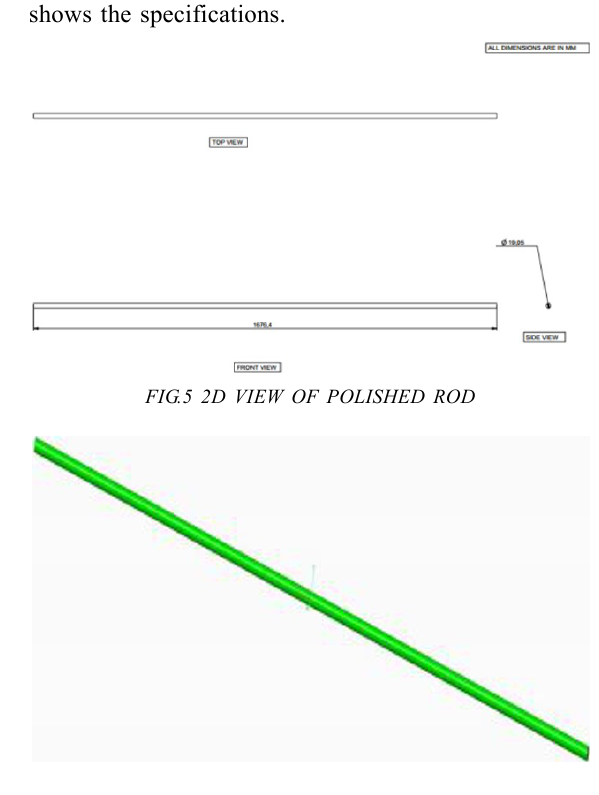
FIG.6 3D VIEW OF POLISHED